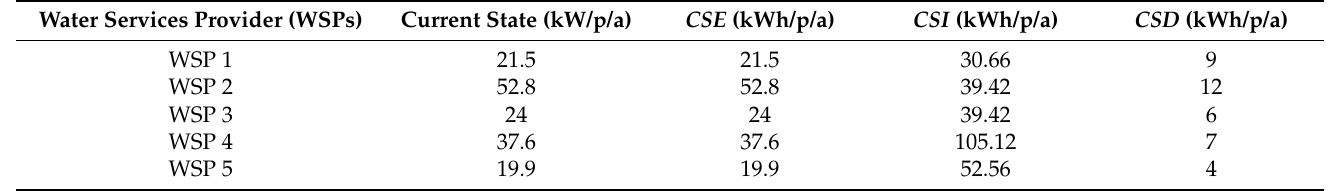
Figure 3. Estimates of energy intensity for water production with the three scenarios ( Current State Extends (CSE) , Current State Improves (CSI) and Current State Deteriorates (CSD) for 2030 compared to current energy intensity (2019). Note the difference in magnitude for energy intensity between WSP1 ( a ), WSP2 ( b ) & WSP5 ( e ) and WSP 3 ( c ) & WSP4 ( d ). Table 9. Current state Per capita energy use for water supply and across the CSE, CSI and CSD scenarios. Water Services Provider